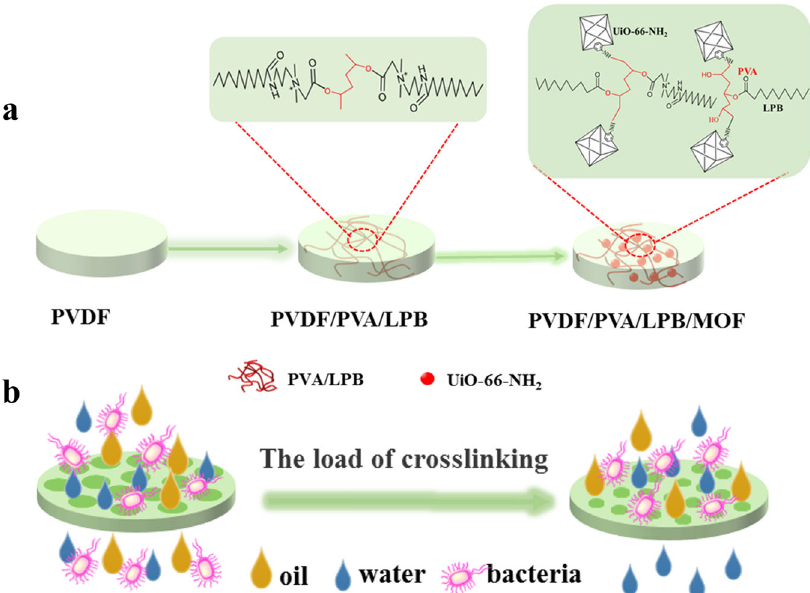
Fig. 1 Schematic diagram of PVDF/PVA/LPB/UiO-66-NH hybrid separation membrane. a Preparation process of PVDF/PVA/LPB/MOF membrane. b Degerming and selective oil/water emulsion separation mechanism of PVDF/PVA/LPB/MOF